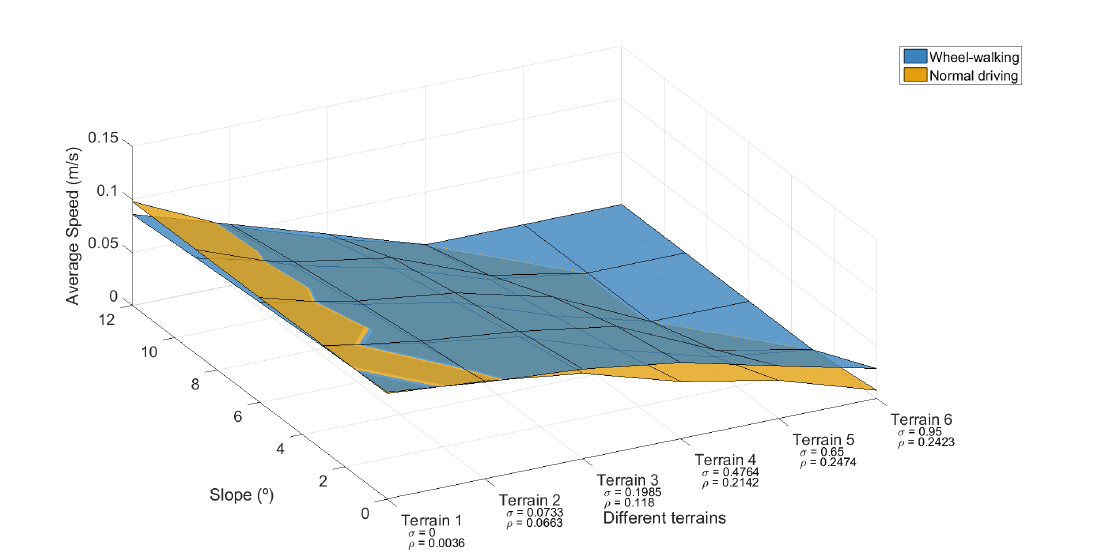
Figure 10. Average speed of wheel walking and normal driving locomotion modes on different terrains. normal driving velocity is higher than wheel walking only for very low σ and ρ .